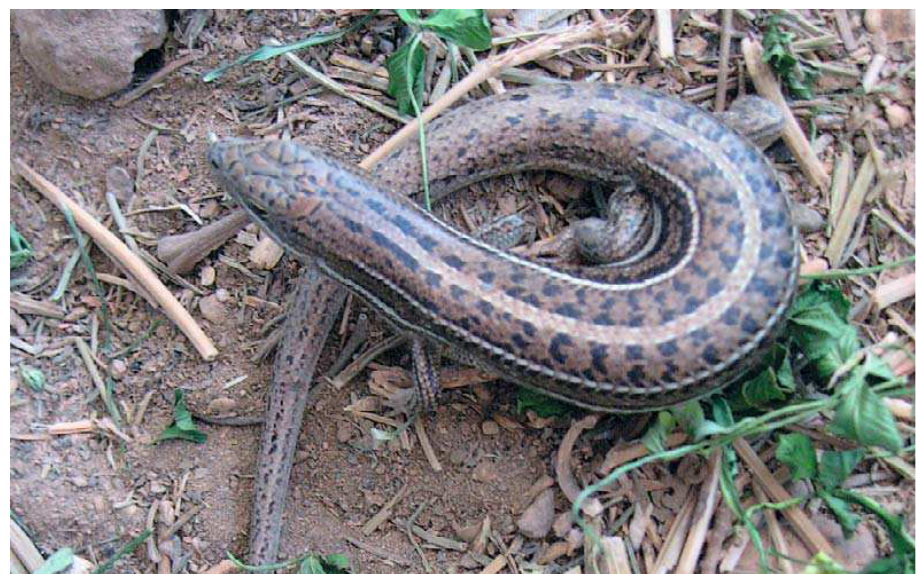
F IGURE 5. Trachylepis vittata from western Iran ( Sarpol-e zahab western Kermanshah ) (photo by R.